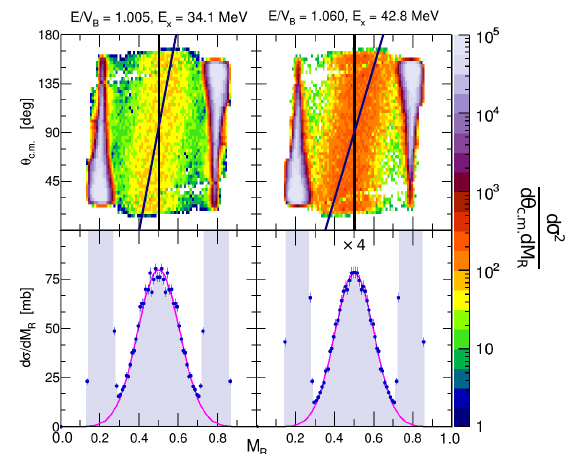
Figure 1. MAD scatter plots (top row) and projections onto the M R axis (bottom row) for the 48 Ca + 186 W reaction at two di ff erent energies. The centre-of-mass energies with respect to the Coulomb barrier, E / V B , and the excitation energies, E x , are shown at the top of each plot. The intensity scale represents the double di ff erential cross section, d σ 2 / d θ c . m . dM R in mb / rad, per pixel. The multiplicative factor scales the y-axis that is shown for the M R distributions for each plot. The blue lines highlight the strong mass-angle correlation present in this reaction.